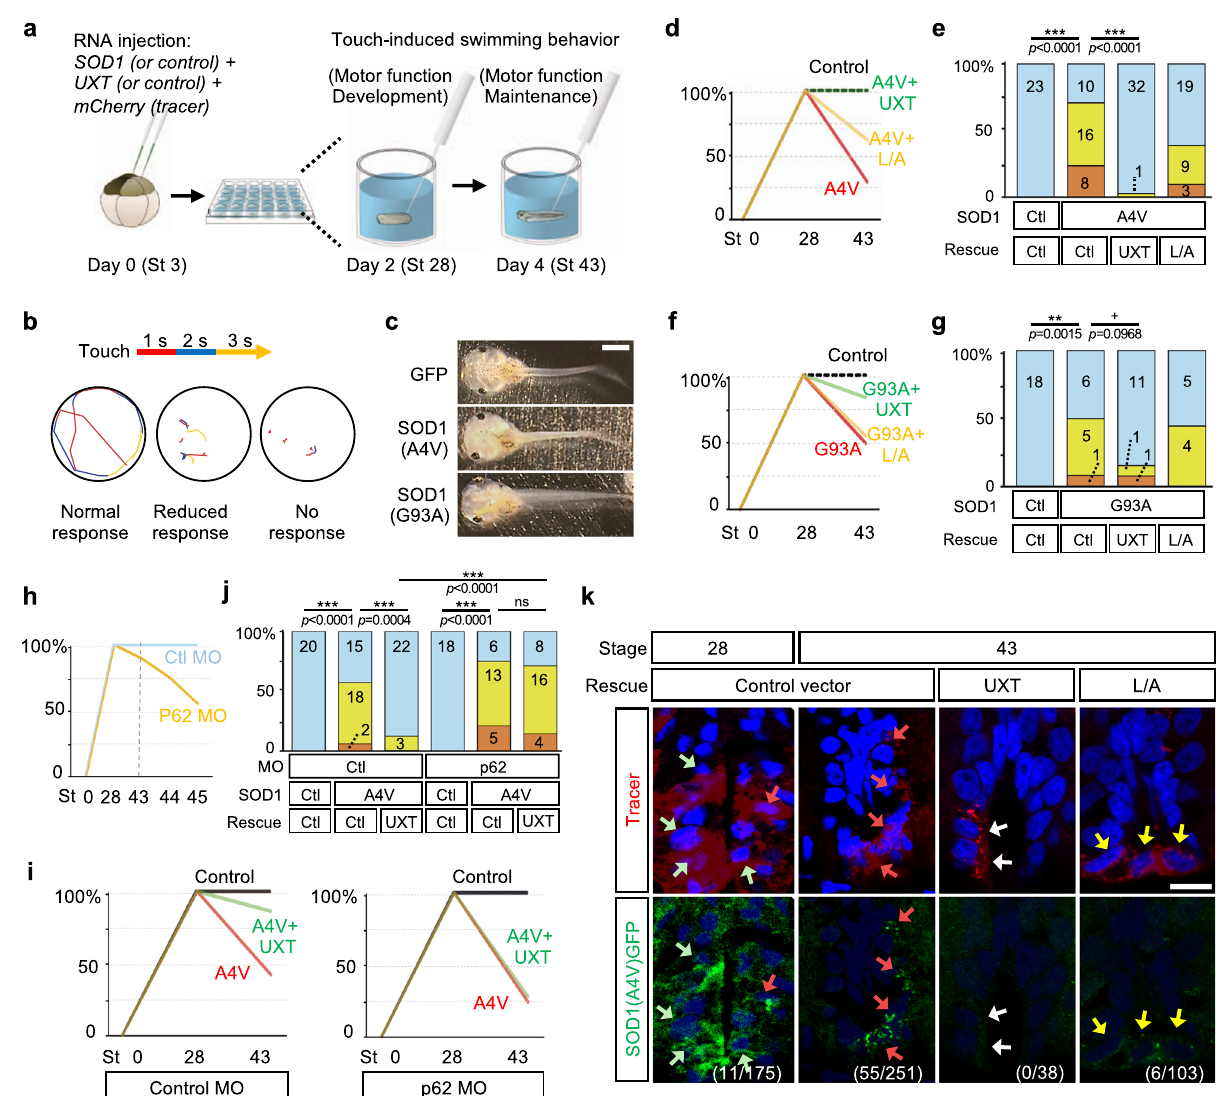
Fig. 7 UXT prevents SOD1(A4V)-induced progressive loss of motor ability in Xenopus. a SOD1 and/or UXT in vitro-transcribed capped RNA were expressed in the central nervous system by targeted microinjection. Motor function was assessed by touch-induced swimming responses at stages 28 and 4. b Each tadpole was touched three times on its tail. Each trace in a circle indicates swimming trajectory of the same tadpole within 3 s (time after the touch is color-coded). The best response of three trials was used to classify the swimming ability. c Injecting SOD1 mutant genes did not result in distinguishable morphological changes. Scale bar, 2 mm. d Swimming responses of tadpoles injected with SOD1 mutant and/or UXT (wild type or L50A/ L59A mutant) in vitro-transcribed capped RNA are shown. The behavior of tadpoles was recorded in three independent experiments. The Y -axis indicates the percentage of tadpoles showing a normal swimming response, and the X -axis indicates developmental stages. e Quanti fi cation of d at stage 43 with the number of tadpoles in each category is shown. Cyan, yellow, and orange bars represent normal, reduced, and no swimming responses, respectively. The Y - axis indicates the percentage of tadpoles. Ctl control; *** p < 0.001 (two-sided Fisher ’ s exact test). f , g Effect of UXT expression on SOD1(G93A)-GFP- induced motor de fi cit was tested as in d and e . + p = 0.0968; ** p < 0.01 (two-sided Fisher ’ s exact test). h , i Effect of a p62 translation-blocking antisense morpholino (MO) on swimming responses was analyzed as in d and e . j Quanti fi cation of i at stage 43 as in e . *** p < 0.001 (two-sided Fisher ’ s exact tests). ns not signi fi cant. k SOD1(A4V)-GFP was visualized by immunohistochemistry in cell bodies of lower motor neurons localized in the ventral horn of the spinal cord. Red and green arrows indicate SOD1(A4V)-GFP aggregation and SOD1(A4V)-GFP, respectively. Co-injecting UXT completely prevents SOD1 (A4V)-GFP aggregation indicated by white arrows. In cells co-injected with UXT(L50A/L59A (L/A)), the SOD1(A4V)-GFP aggregation is often observed as indicated by yellow arrows. Numbers in parenthesis indicate the number of cells with aggregation/the number of transfected cells analyzed. Scale bar, 10 µ